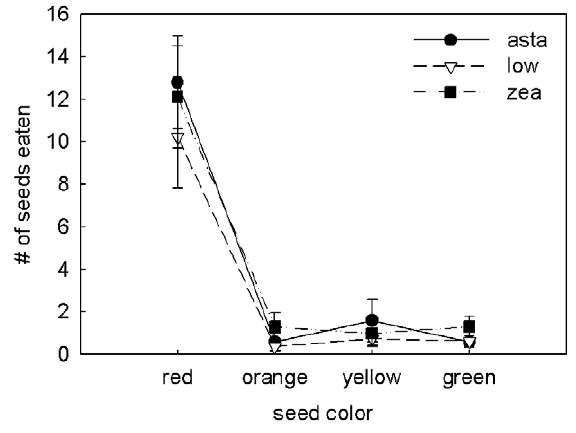
Figure 5. Food color preferences of carotenoid-supplemented birds. Mean 6 S.E. number of seeds dyed each of four colors eaten during the 20 min food preference trial. Diet treatments are denoted with different symbols.